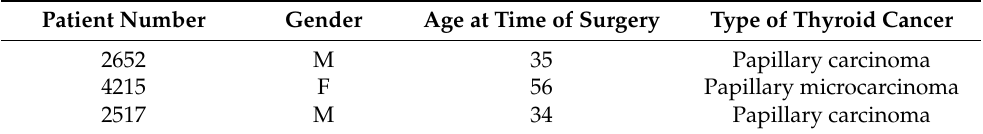
Table 1. Patient sample information used in this